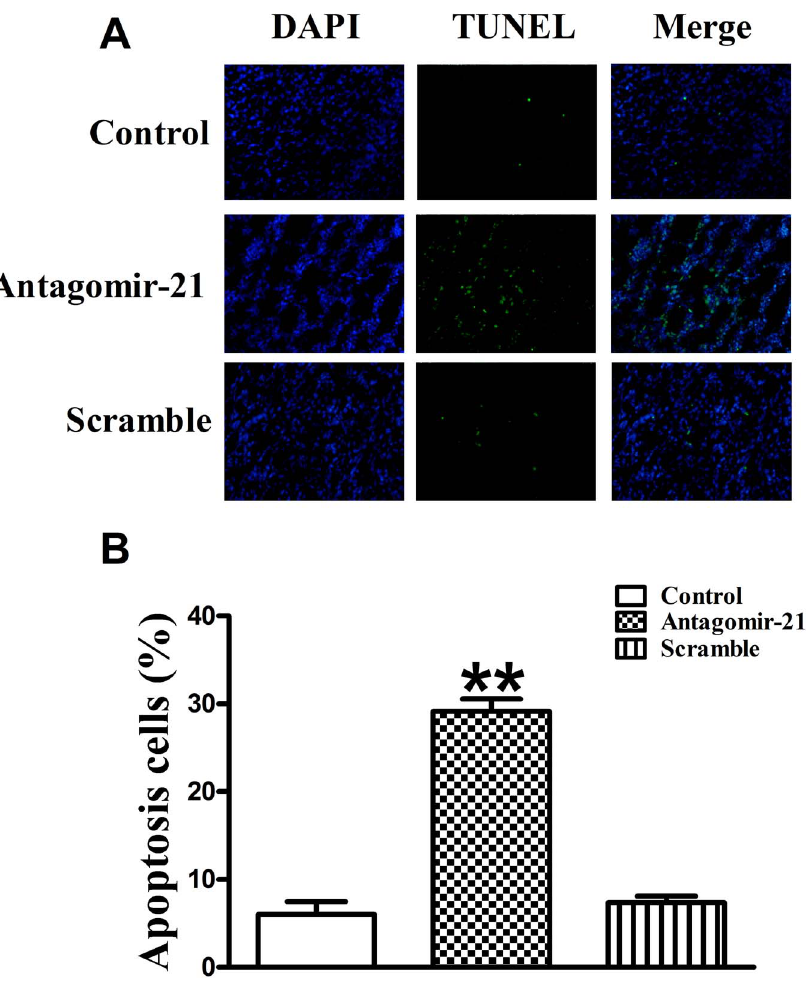
Figure 6. The effect of antagomir-21 on tumor cell apoptosis. Cell apoptosis was determined by TUNEL staining. (A) Green color is apoptotic cell stained by TUNEL; blue color is the cell nucleus stained by DAPI. Images were taken at a magnification of 6 200. (B) Quantification of cell apoptosis from conditions in A. Data are expressed as mean 6 SEM, n=10, ** P , 0.01 vs control group.